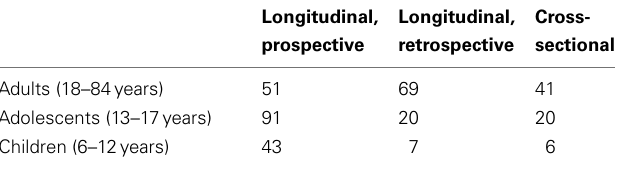
Table 3 | Number of studies of different design by different age groups.